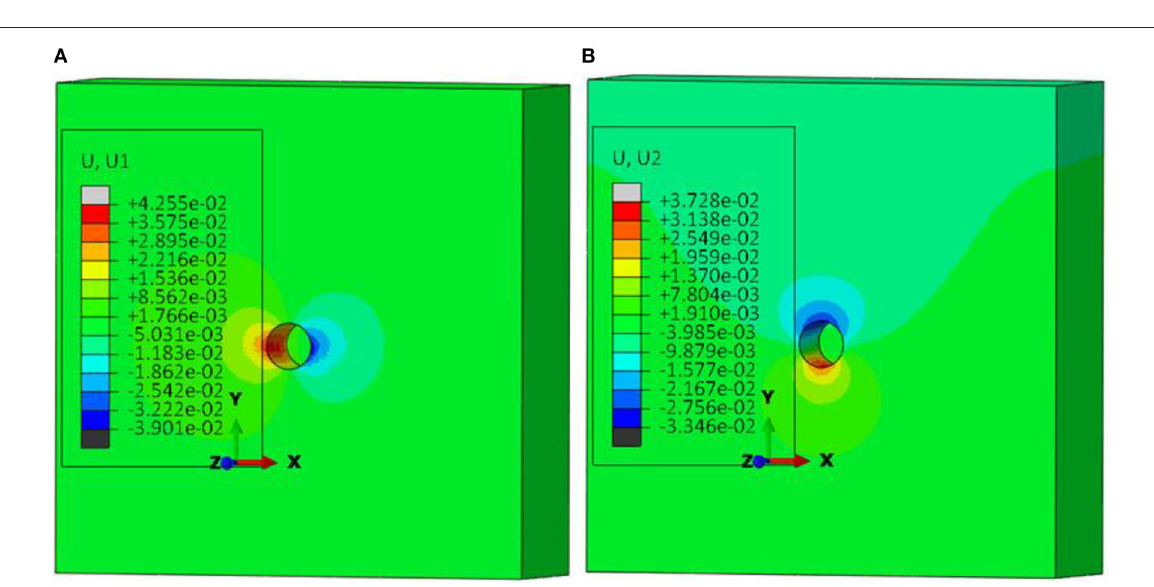
vertical displacement, which is consistent with the law that the horizontal stress is greater than the vertical stress in field stress test. In addition, in the horizontal displacement, the convergence value of the left is larger than that of the right. presents a “S” shape with tunnel excavation. Before the tunnel floor heaven, left or right sidewall convergences are 9.43,